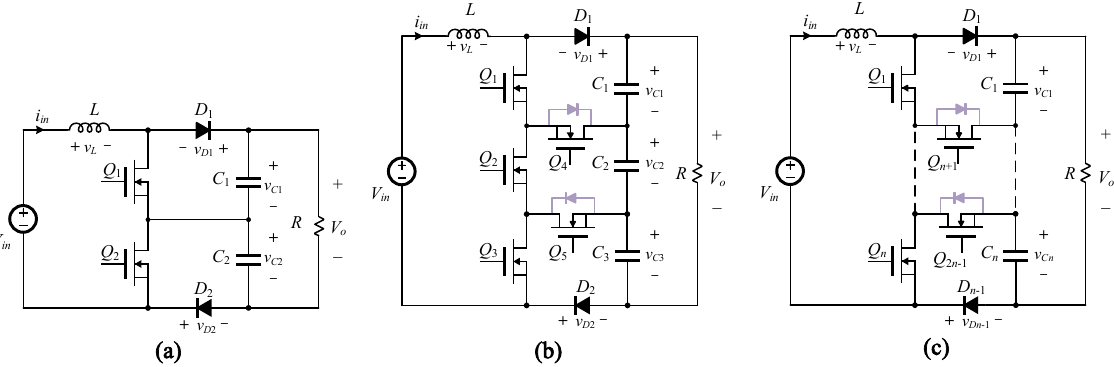
Figure 2. Illustration of multilevel step-up DC-DC converter topologies: ( a ) three-level boost converter; ( b ) four-level boost converter; ( c ) n -level boost converters.